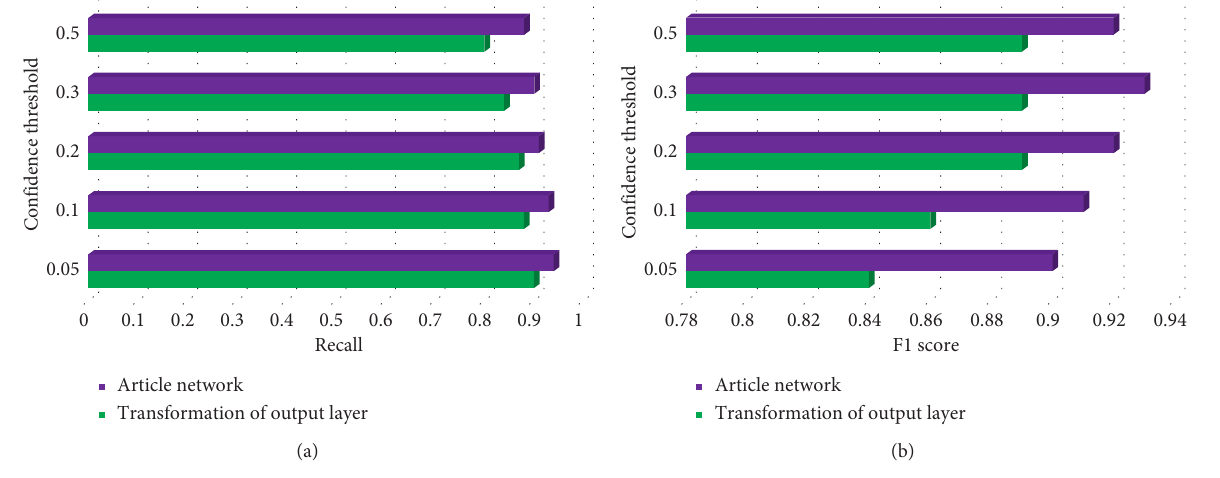
Figure 4: Comparative analysis chart of network indicators. (a) Recall index. (b) F1 index.